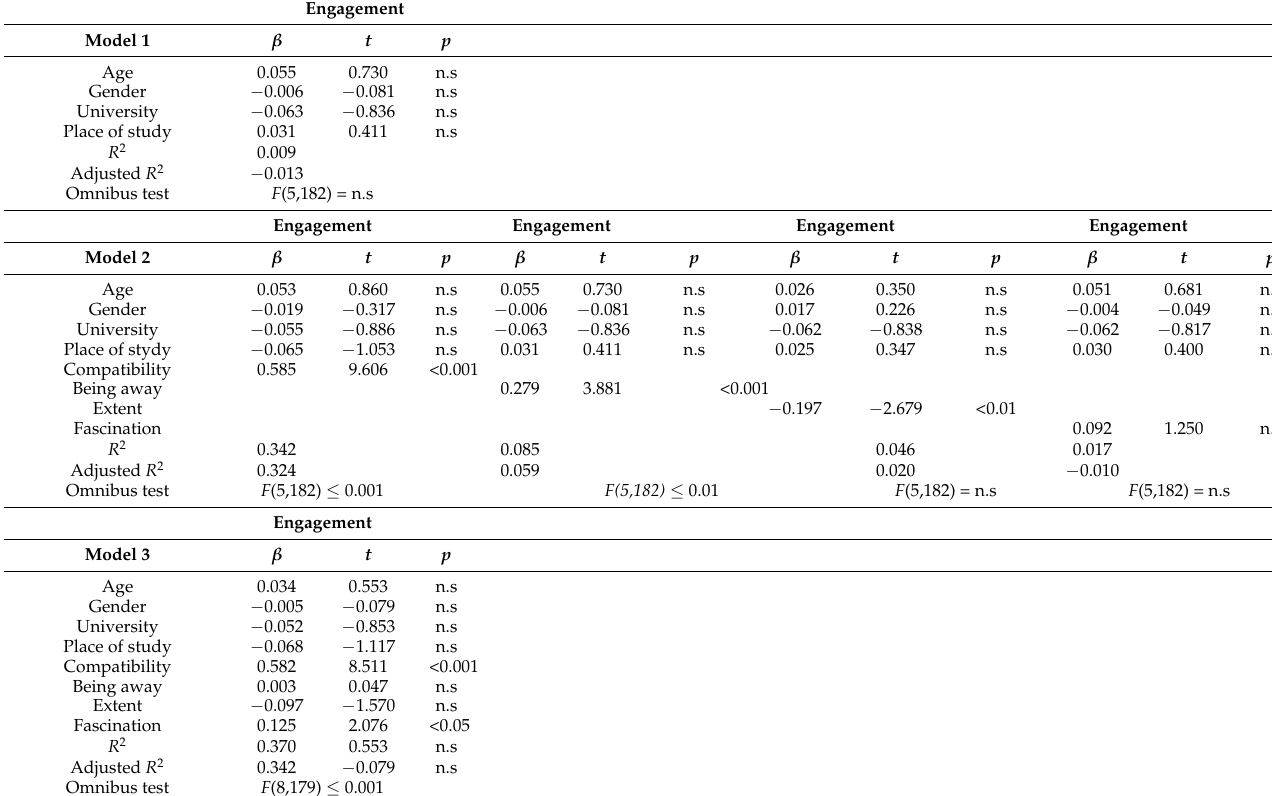
Table 3. Hierarchical regression analyses of the independent and interactive associations between socio-demographic and contextual variables and sub-dimensions of perceived restorativeness (com- patibility, extent, being away, fascination) with engagement (N =